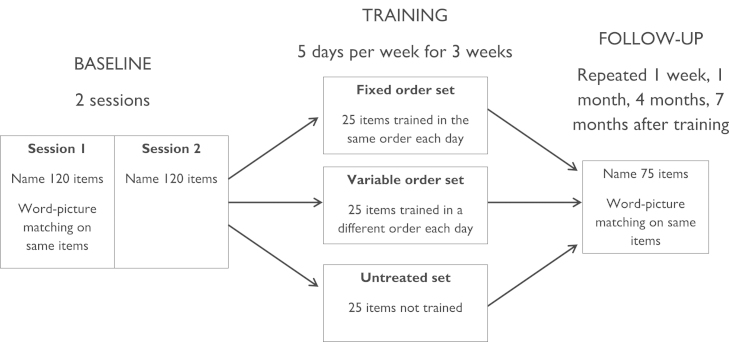
Design of Study 1.